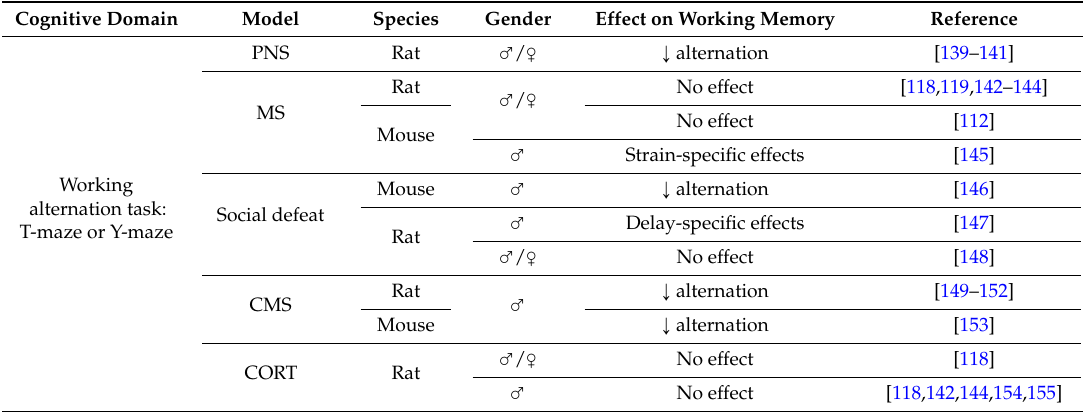
Table 4. Working memory performances in different models of